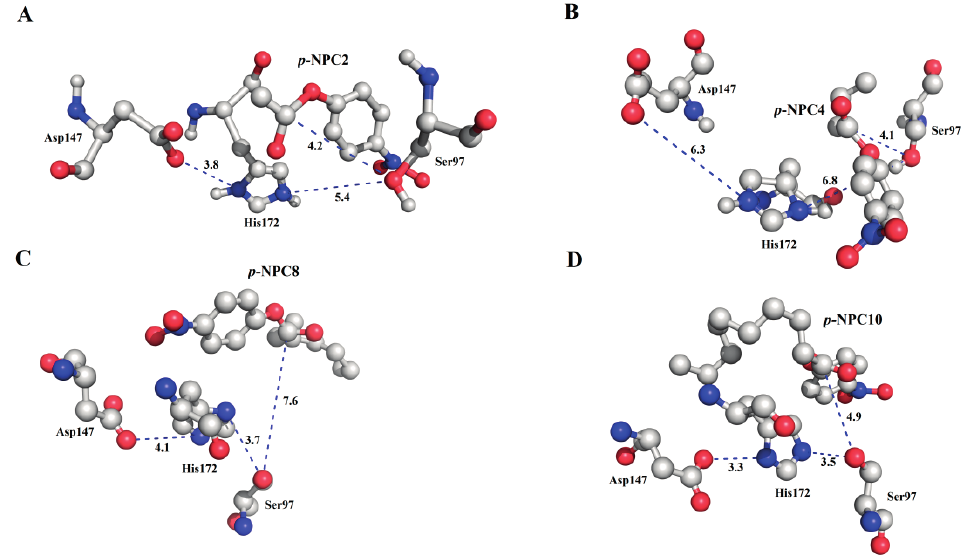
of P186_1588 and p -NPC8; ( D ) The binding pose for the complex of P186_1588 and p -NPC10.